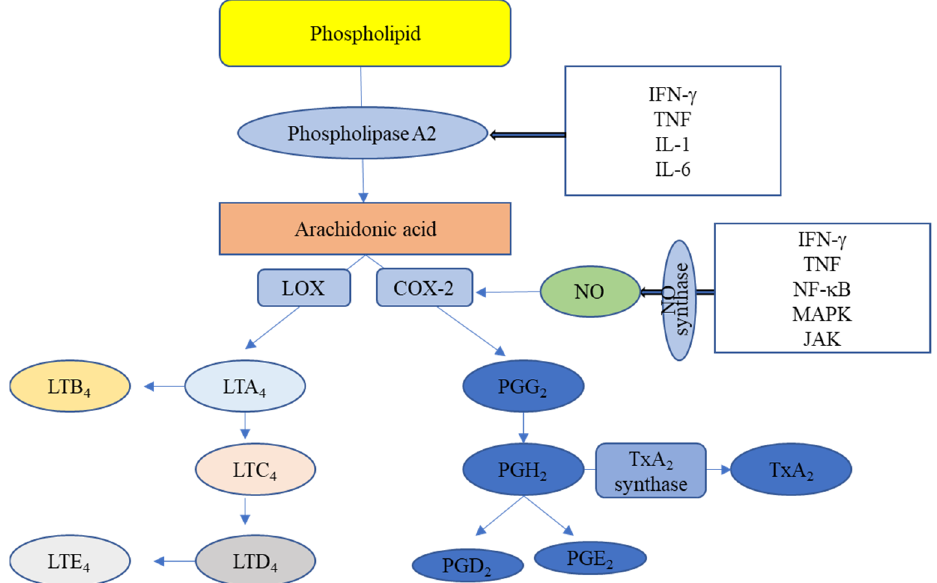
Figure 1. The biochemical process of inflammation. COX—cyclooxygenase; LOX—lipoxygenase;